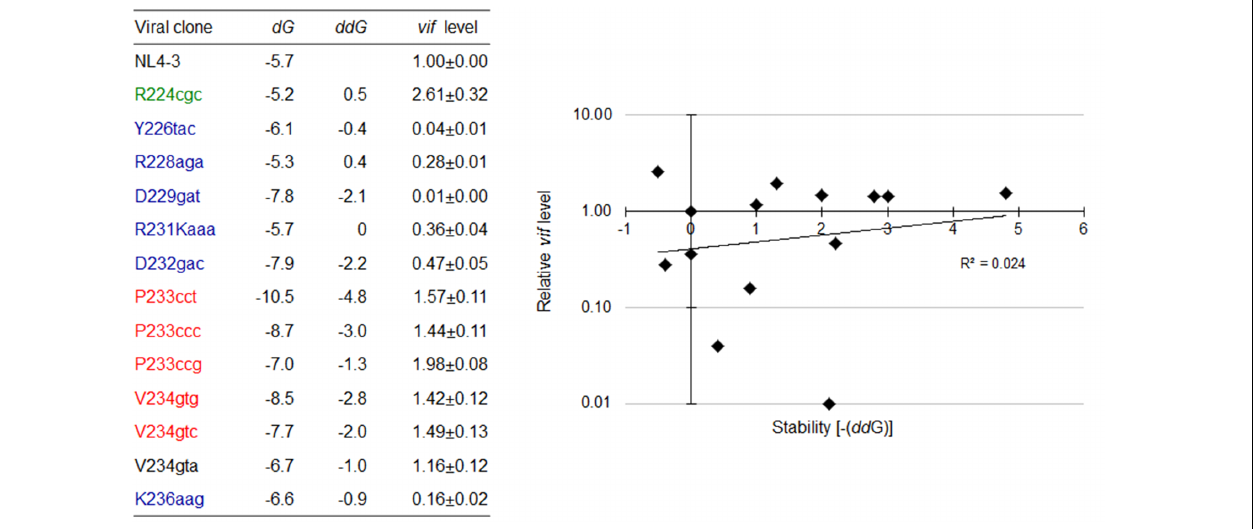
FIGURE 7 | Changes in vif expression level and SLSA1 RNA stability by nSNVs within SLSA1. Free energy ( d G) for the SLSA1 sequence carrying an nSNV was predicted by mfold program (Zuker, 2003). RNA stability ( dd G) is presented as difference of free energy between each nSNV and NL4-3. For determination of vif production level, proviral clones indicated were transfected into 293T cells, and at 20 h post-transfection, DNase I-treated total RNAs were prepared. After synthesis of cDNA using DNase I-treated RNA and oligo (dT) primer, samples were subjected to qRT-PCR analysis using a specific primer set for vif mRNA. Expression levels of all HIV-1 mRNA species and GAPDH mRNA were analyzed by qRT-PCR in parallel for transfection and internal controls, respectively. A vif expression level in each sample was normalized by those of all HIV-1 mRNA species and GAPDH mRNA. Vif expression levels relative to that by NL4-3 are presented. Mean values ± SD from three independent experiments are shown. Scatter diagram on the right was created by plotting vif expression levels and SLSA1 stabilities [–( dd G)] of variant clones with nSNVs relative to those of NL4-3. Exponential trendline and coefficient of determination ( R 2 = 0.024, p = 0.549 by F -test) are shown. Blue, red, and green letters indicate low, high, and excessive vif types (Nomaguchi et al., 2016), respectively. In this figure, the data of relative vif expression levels in our previous report (Nomaguchi et al., 2016) were used for clones R224cgc, Y226tac, R228aga, D229gat, R231Kaaa, D232gac, and K236aag for easy